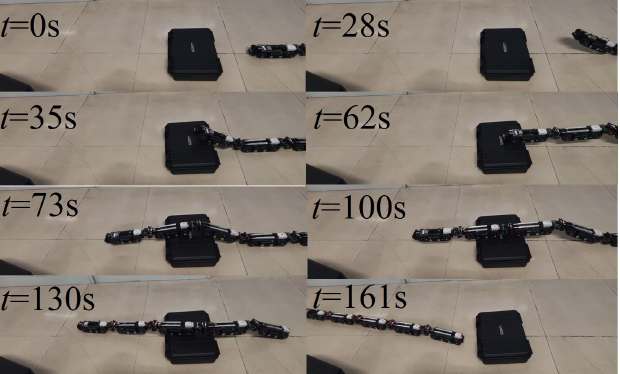
Figure 19. A snake-like robot using combined caterpillar tracks that were invented by humans and joints that mimicked animals to lift itself to cross a tall